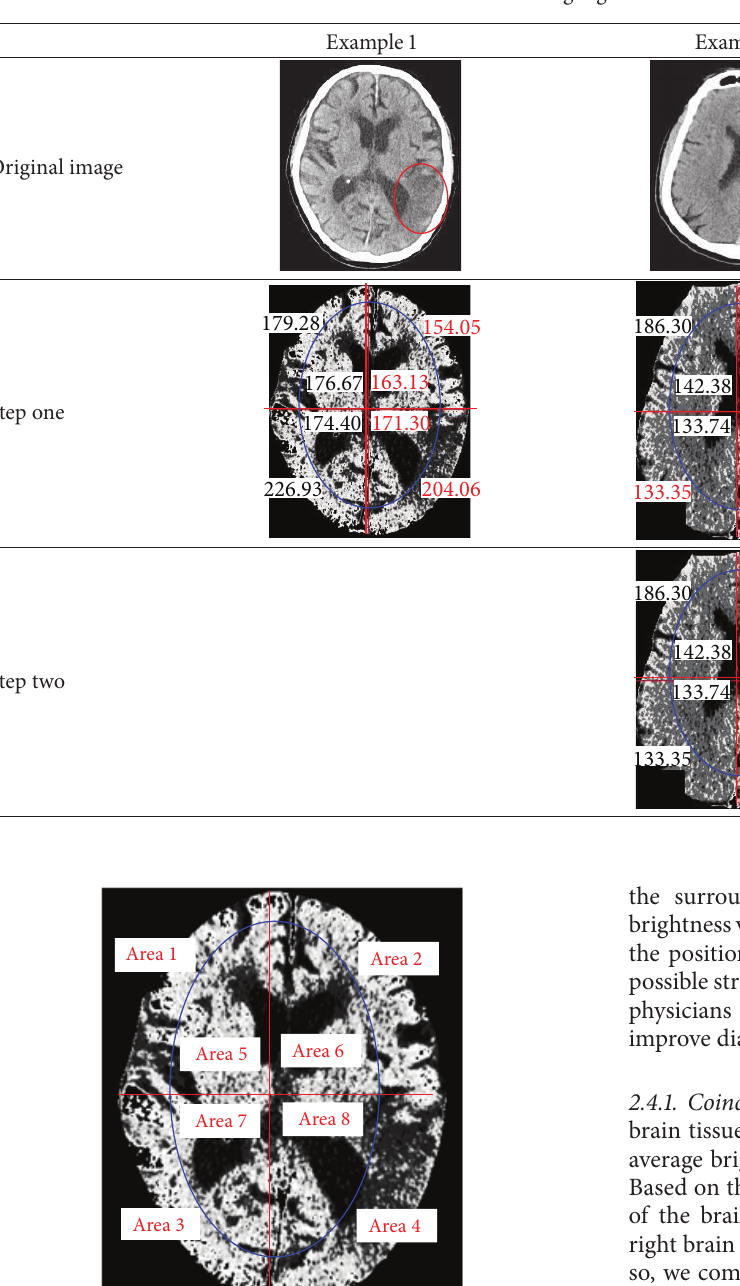
Table 1: Results of coinciding regional locations for different cases.